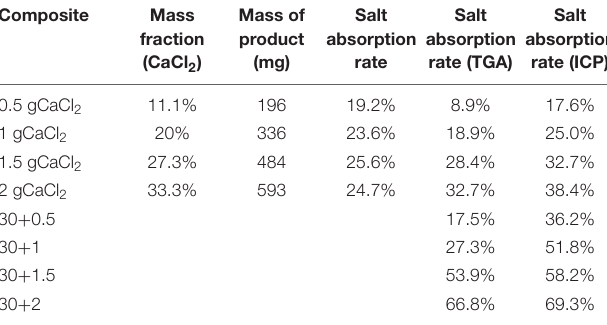
TABLE 1 | Salt mass fraction in the composite